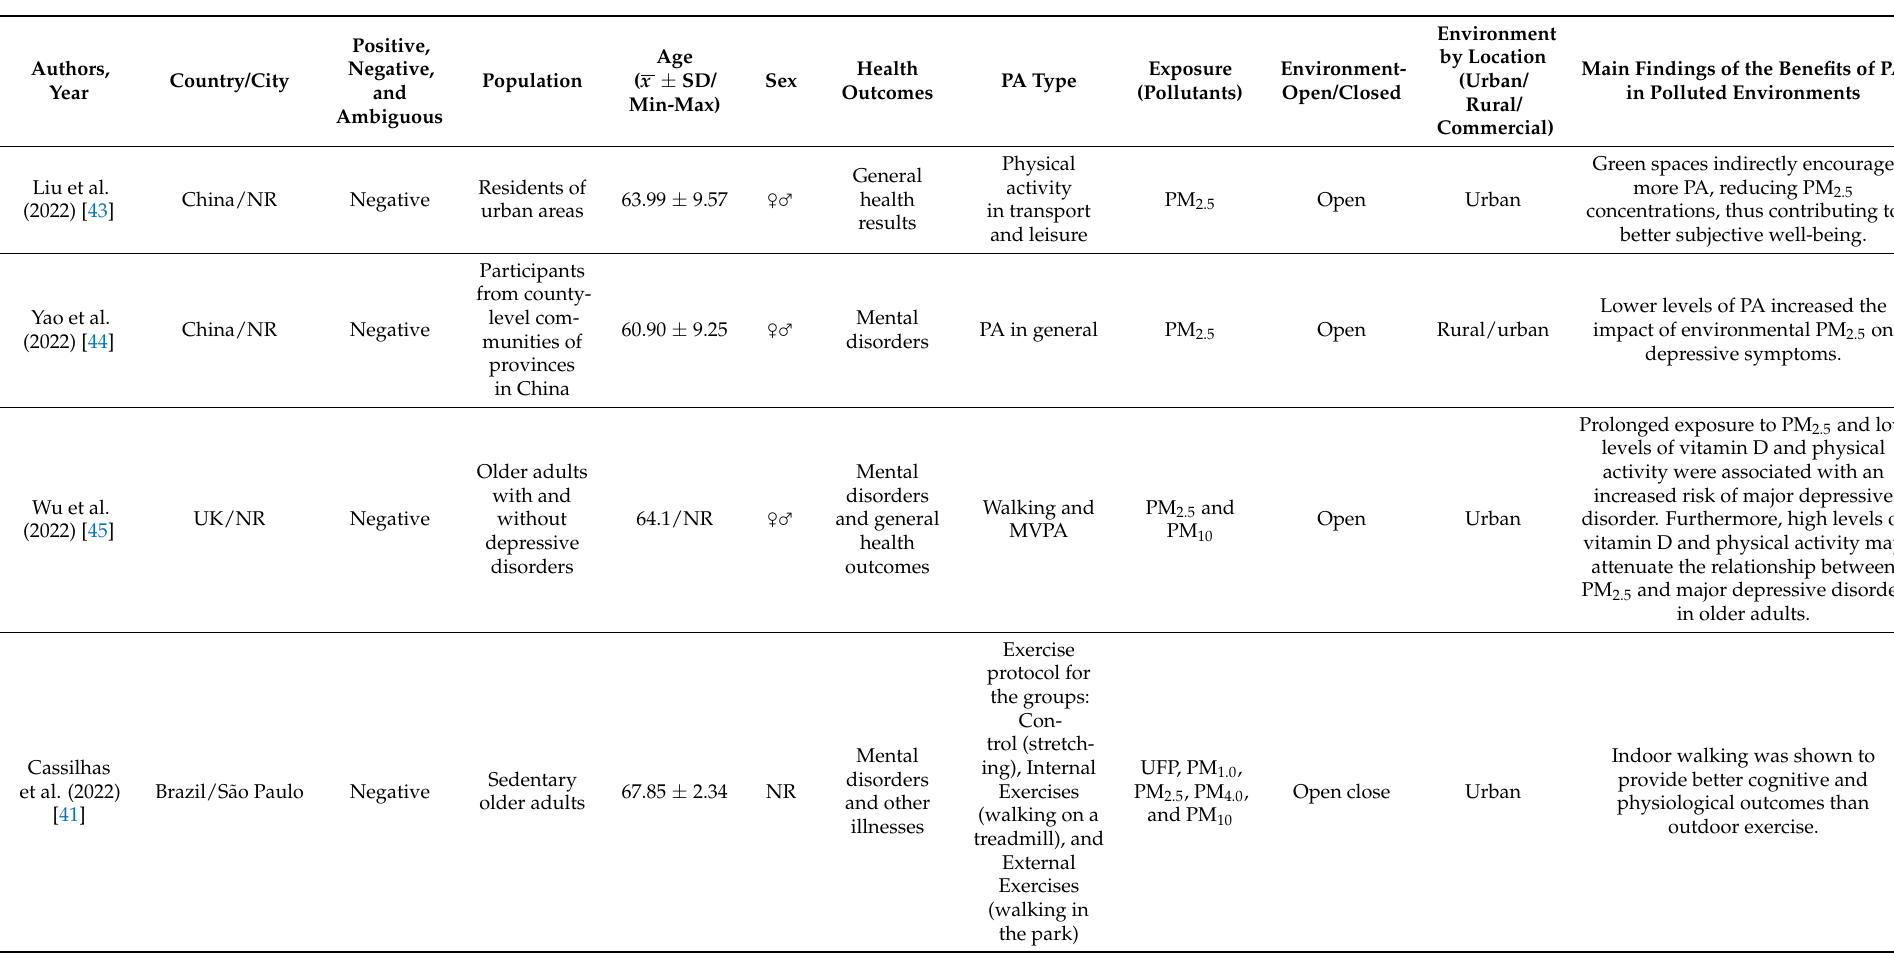
Table 4. Sample characteristics (sex and age), pollutants, physical activity, health outcomes, and findings on the beneficial effects of PA on the health of older adults during exposure to polluted